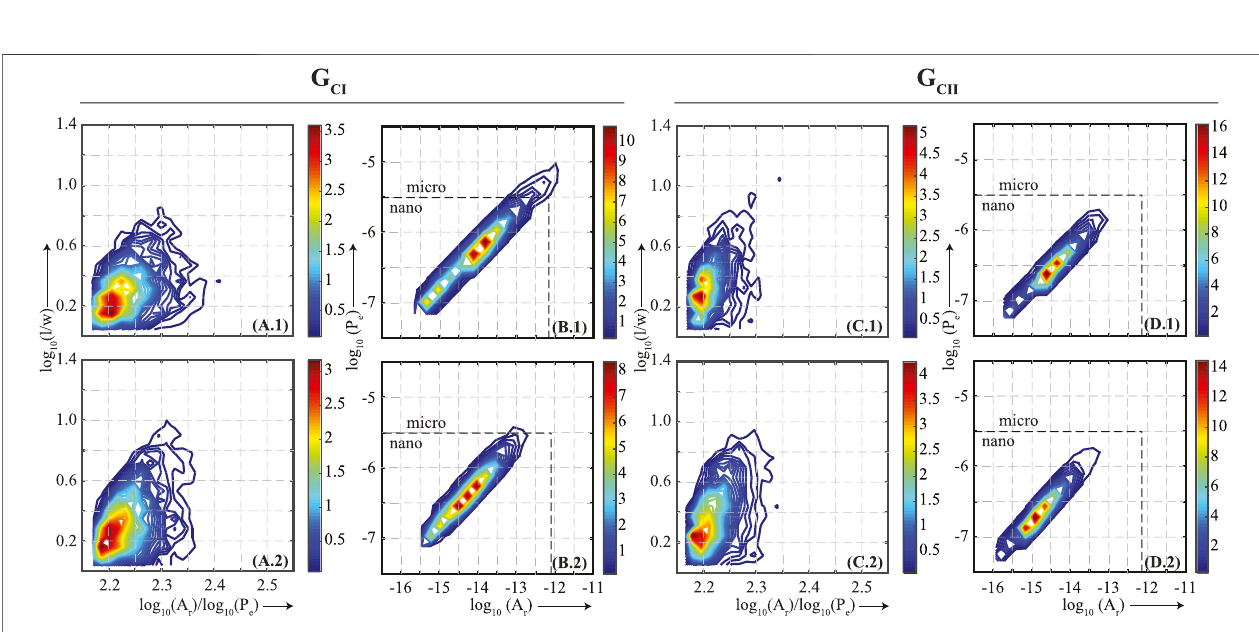
FIGURE7 | Facies C. Symbols and labels are thesameasin Figure 5 . Sample depth, porosity, compositionand gradients for P-(r P ),S1-(r S1 ) and S2-(r S2 ) waves are mentioned in the Table 3 . The fi gure indicates that within the same pore-shape distribution, r P increases as the dominant pore-size decreases.